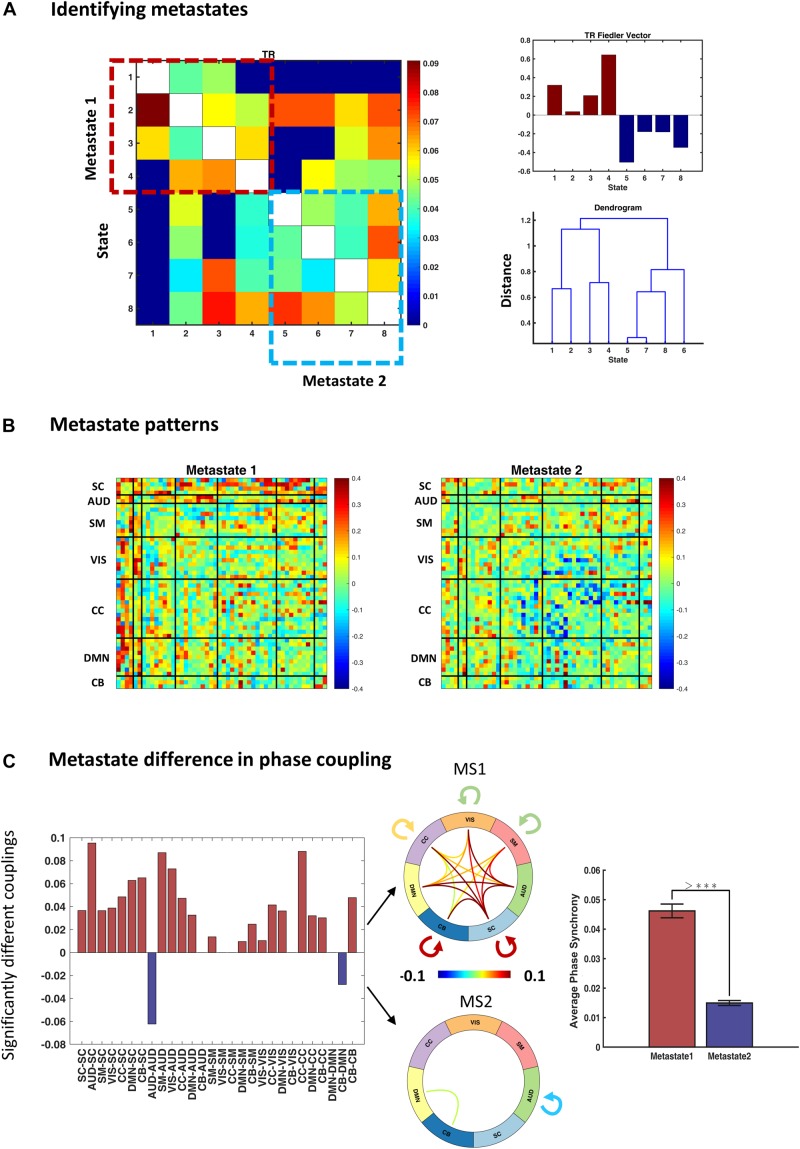
Identifying and characterizing metastates (MS). (A) Metastates are groups of states with higher probability of within-group transitions, than across. States 1–4 and 5–8 show this property, as evidenced by diagonal blocks on the group transition matrix. Entries of the transition matrix (left panel) denote 0.6th quantiles, across subjects. The top right panel shows the Fiedler vector (i.e., the second smallest eigenvector of the graph Laplacian associated with the transition matrix) and the lower panel contains the dendrogram of hierarchical clustering (cophenetic correlation coefficient = 0.22). Both methods acknowledge the same metastates. (B) Average metastate patterns, across subjects. MS1 is clearly more coherent (than MS2) and MS2 is notable for anticoupling of the cognitive control network components. (C) Difference in the phase coupling pattern of the metastates. Left panel: connections that are on average stronger in MS1 (or MS2) were identified using permutation-based paired t tests. Positive (pink) bars show (average) phase couplings that are significantly higher in MS1 than MS2; negative (blue) bars denote the inverse. The two connectograms (middle panel) convey the same information graphically. The bar plot (on the right) shows that average phase coupling is significantly higher in MS1, than MS2 (permutation-based paired t test: p < 1e–4). Error bars stand for standard errors of mean, and >*⁣** indicates p < 1e–4.